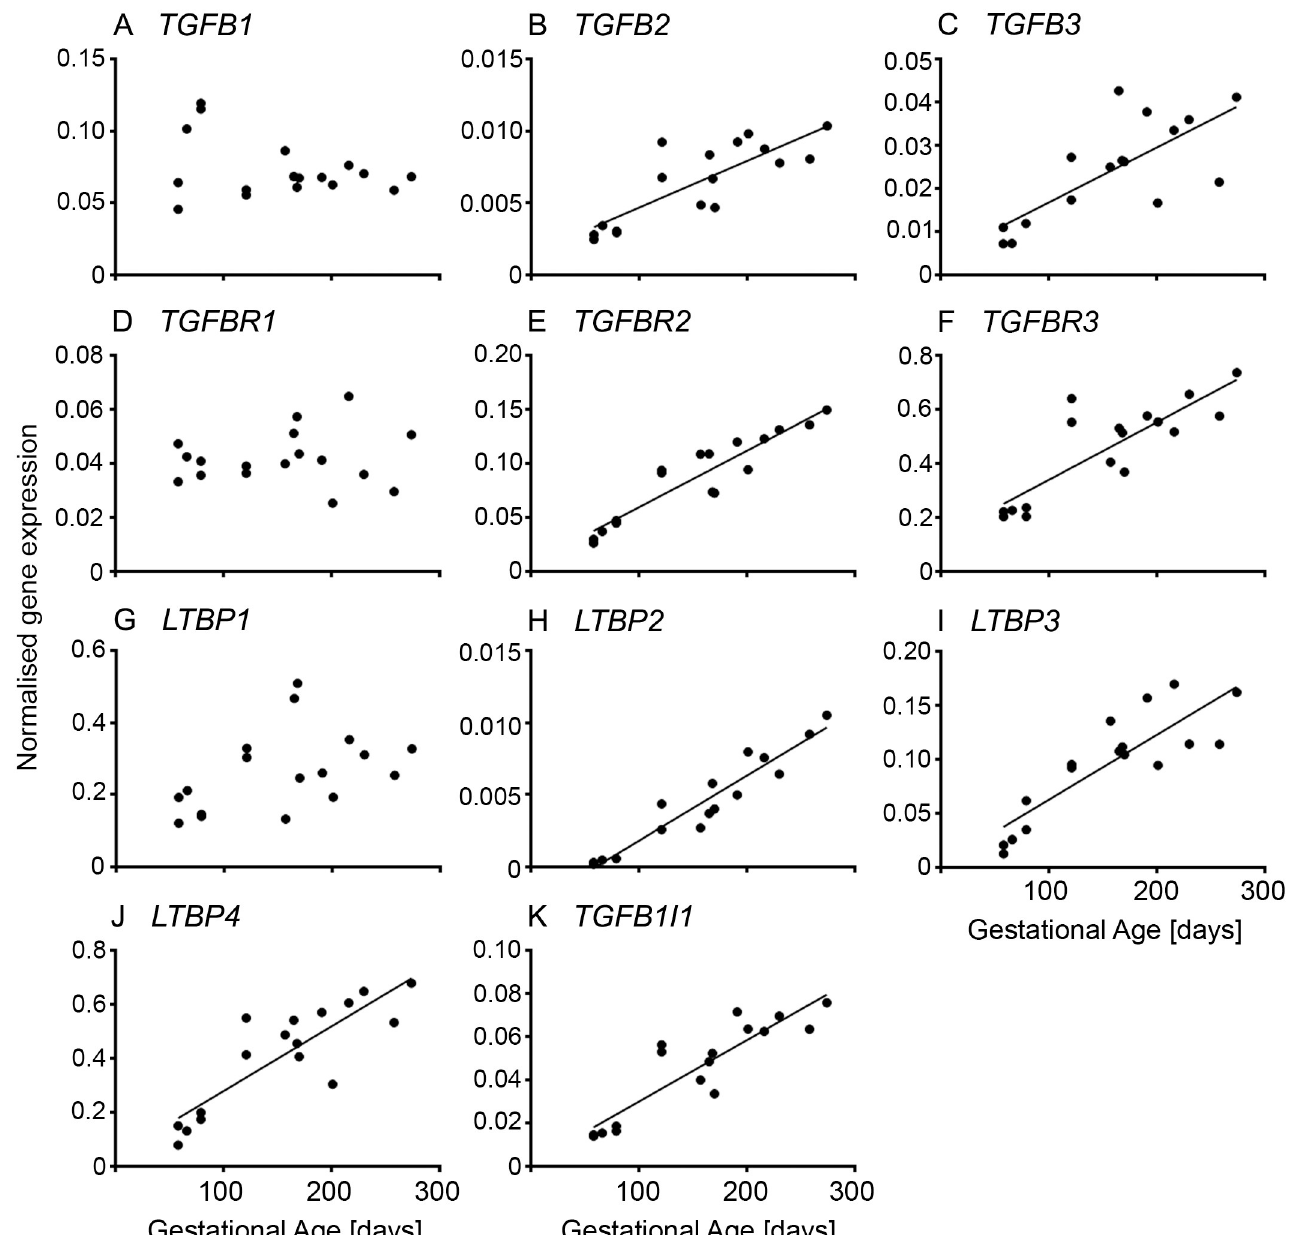
Fig 1. TGF- β signalling pathway in fetal ovarian development. Expression levels of genes for each animal are plotted against gestational age in days (n = 16 or 17 animals).